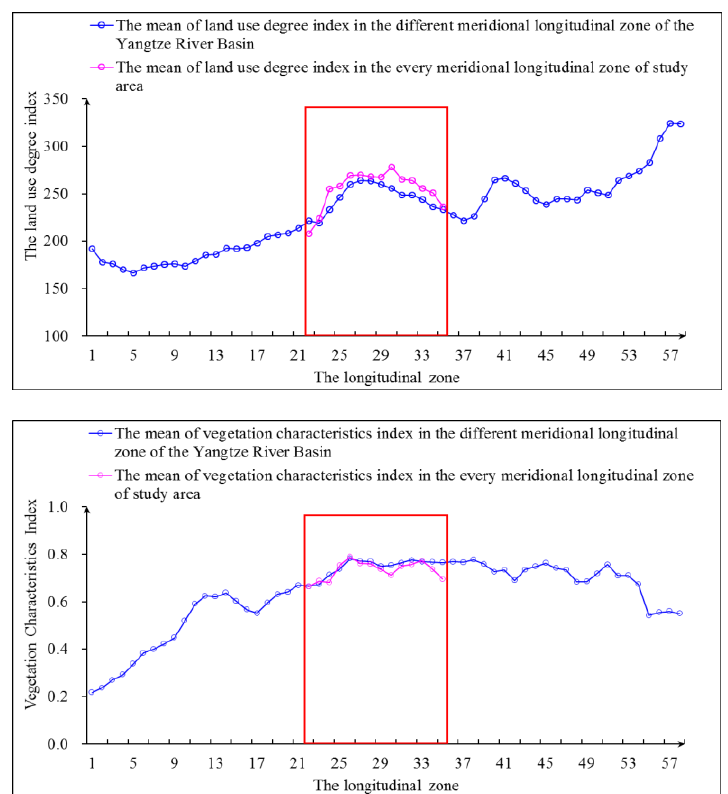
Figure 2. The land use degree index change and natural vegetation characteristics change in the study area and different meridional longitudinal zone of the Yangtze River Basin. Int. J. Environ. Res. Public Health 2018 , 15 , x FOR PEER REVIEW